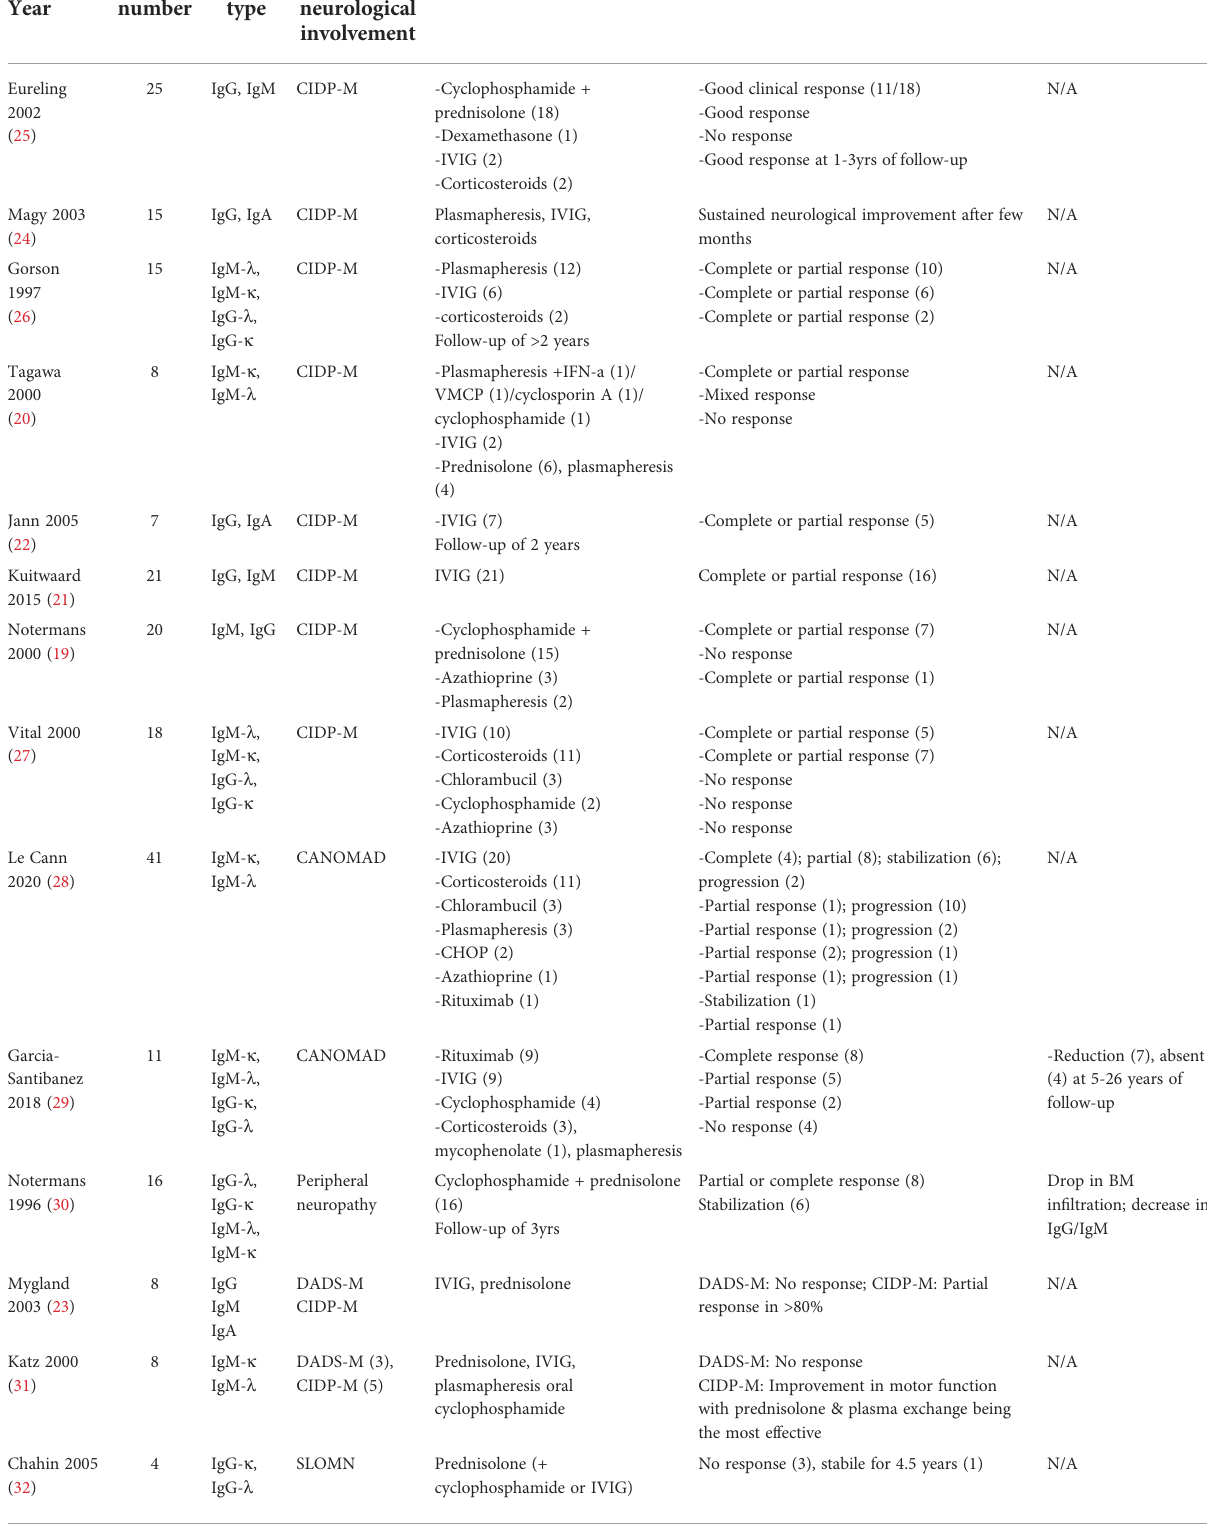
TABLE 2 Literature review on the management of MGUS-related peripheral nervous system